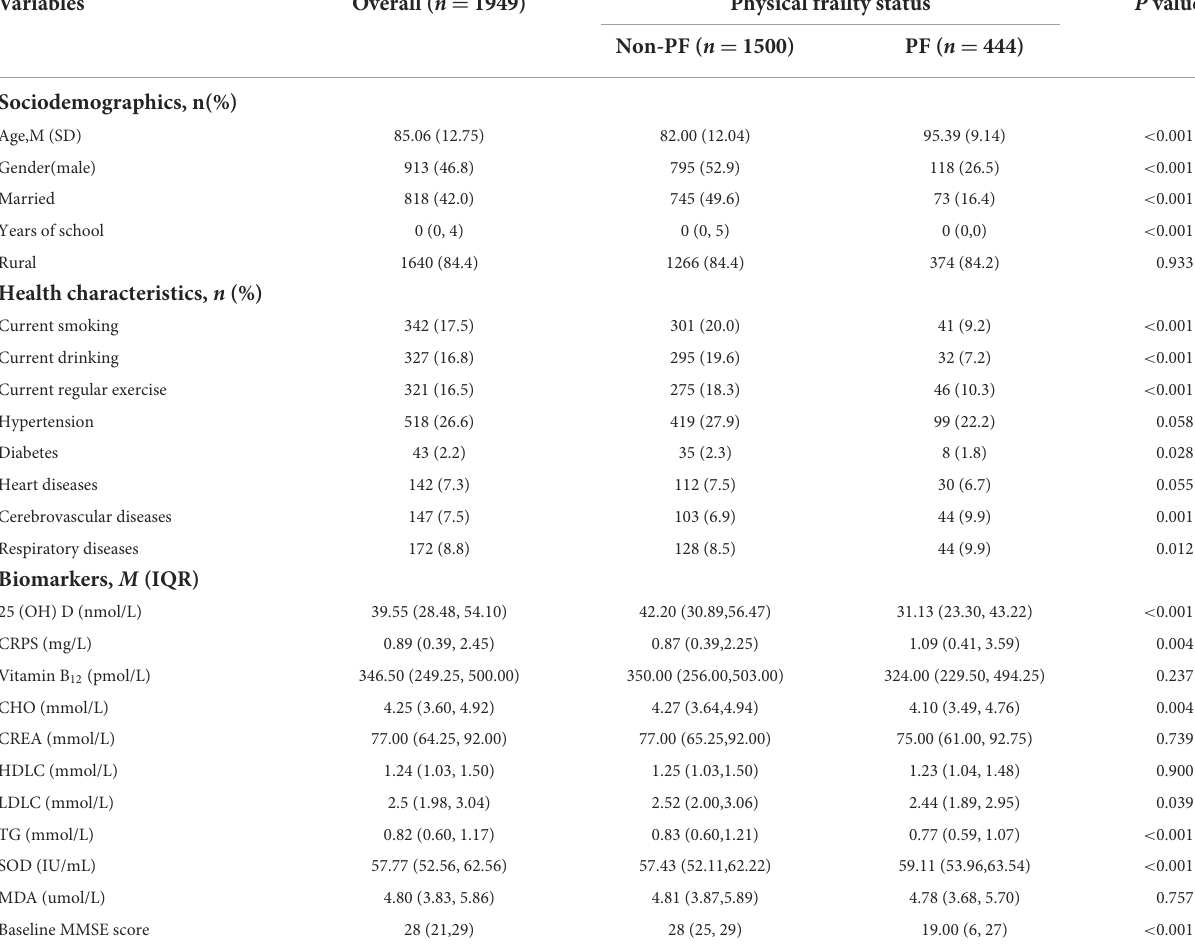
TABLE 1 Sample characteristics according to periodontal